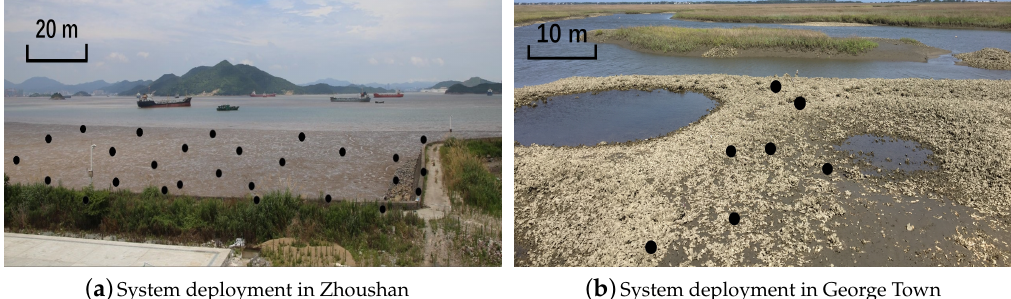
Figure 1. Wireless sensor networks in intertidal zones. We deploy 27 nodes in Zhoushan system and seven in George Town